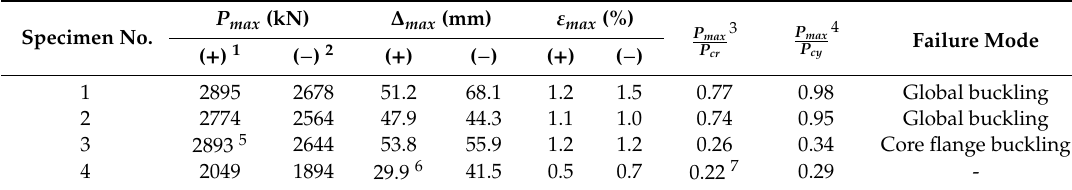
Table 3. Test results.